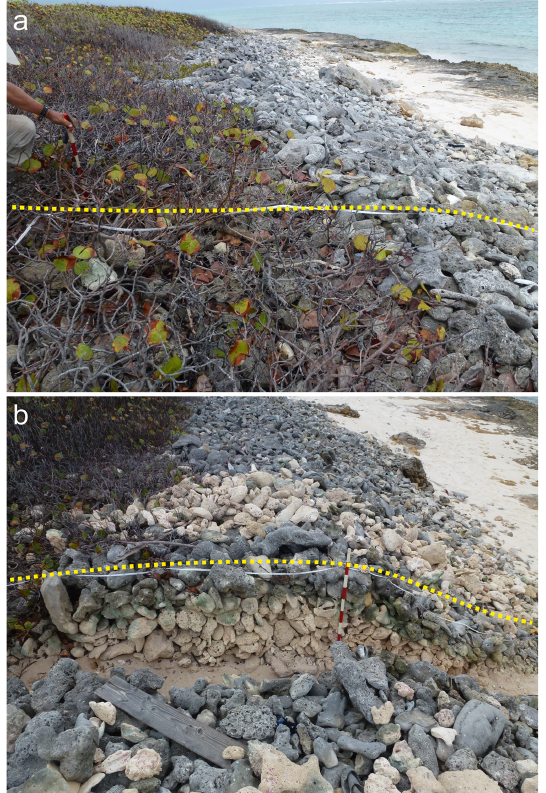
Fig. 2. Typical ridge deposits on Anegada. (a) Ridge transect I, and (b) transect II, both resting on top of a 0.5–1.3m high limestone platform (yellow line marks survey line).